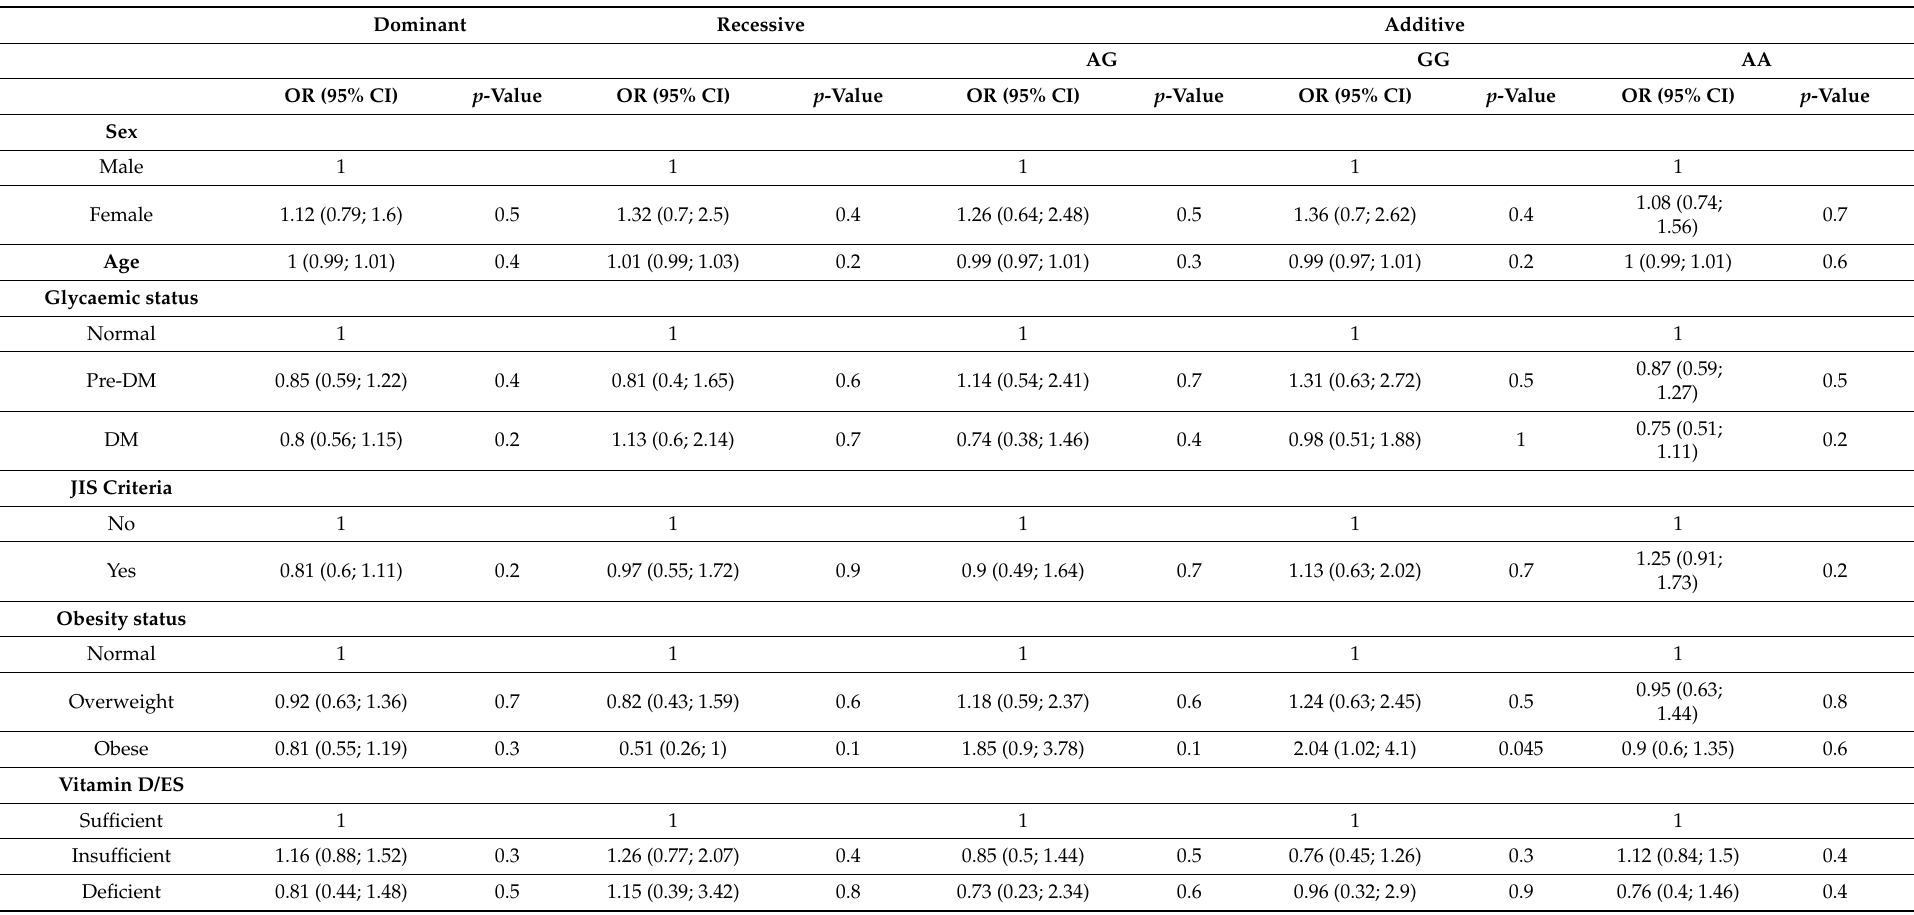
Table 5. Logistic regression for dominant, recessive, and additive models for single-nucleotide polymorphisms rs2228570 . Dominant